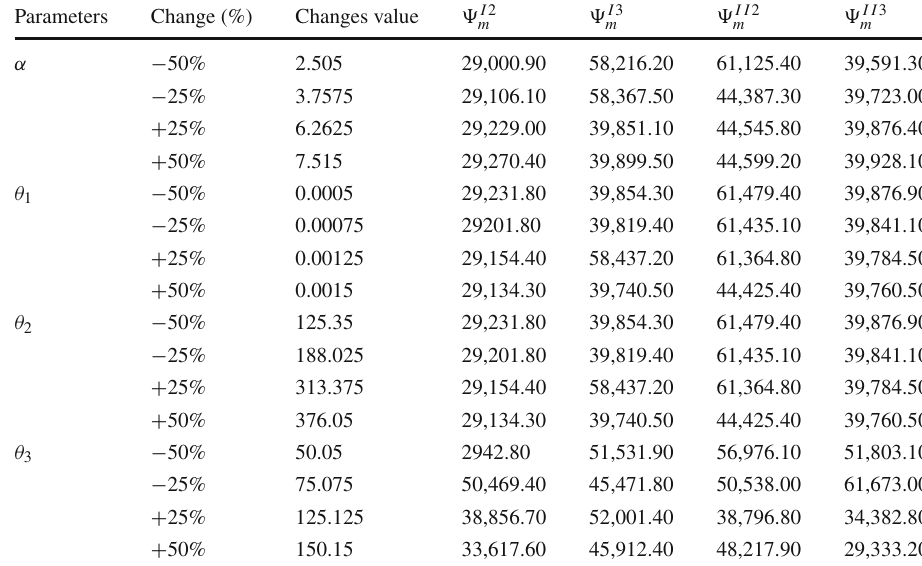
Table 10 Parameters changes value versus manufacturer’s profit in different cases